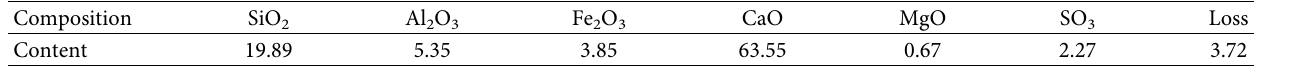
Table 11: Chemical composition of Portland cement (%).